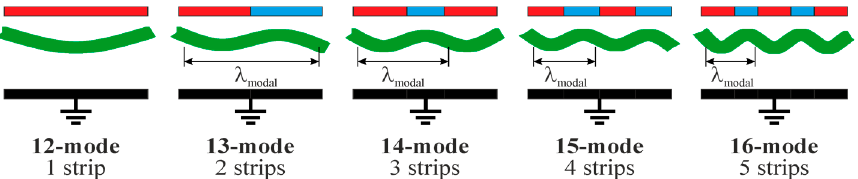
Figure 2. Schematic of the modal shapes and sign (red and blue for positive and negative applied voltage) of electrode potential in cross sectional view. The modal wavelength ( 𝜆 𝑚𝑜𝑑𝑎𝑙 ) is also indicated. The corresponding dies were glued and wire-bonded in 24-pin DIP packages, whose cavity serve as fluid cell when closed by a thin cover glass on the top (see Figure 3). A small quantity of fluid (~100 µ L) was placed inside this cell and the measurements were taken at room temperature (25 ± 1 ◦ C).